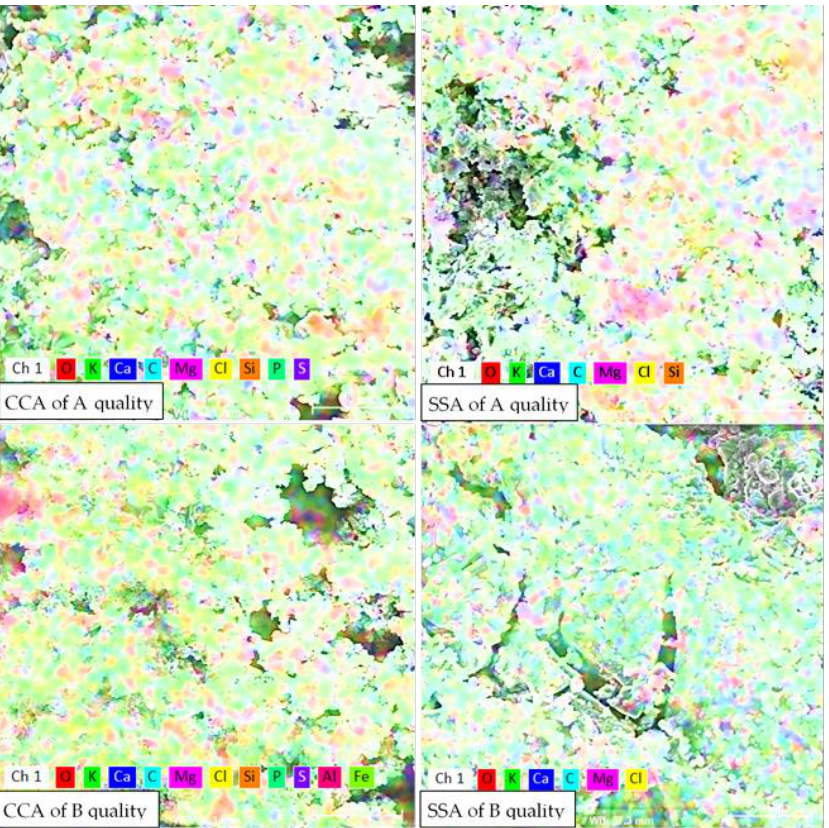
Figure 4. The distribution of the main identified elements in CCA and SSA, identified by EDS analysis, at the magnification rate of 80 µm.